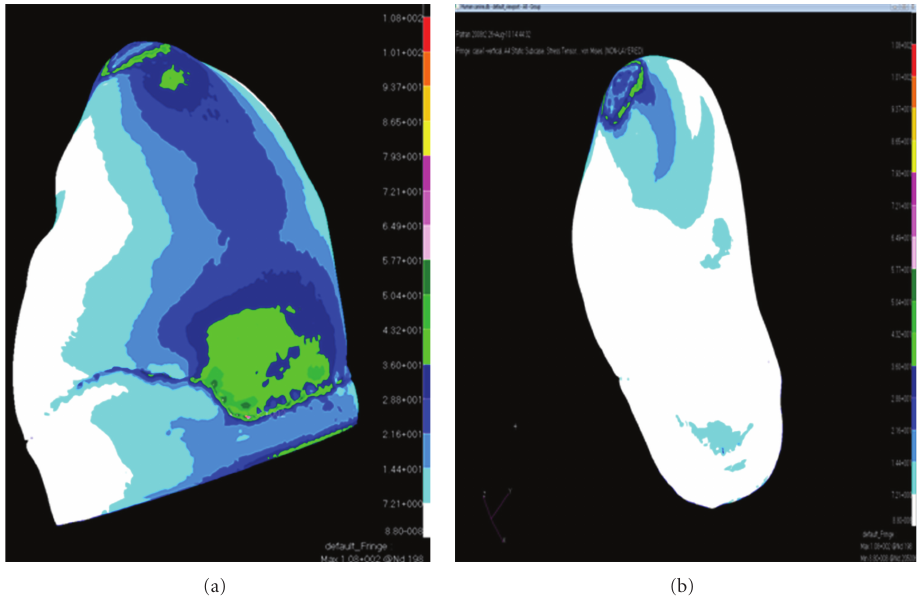
Figure 2: von Mises stress distribution caused by 100 N vertical load ((a) buccal view and (b) lingual